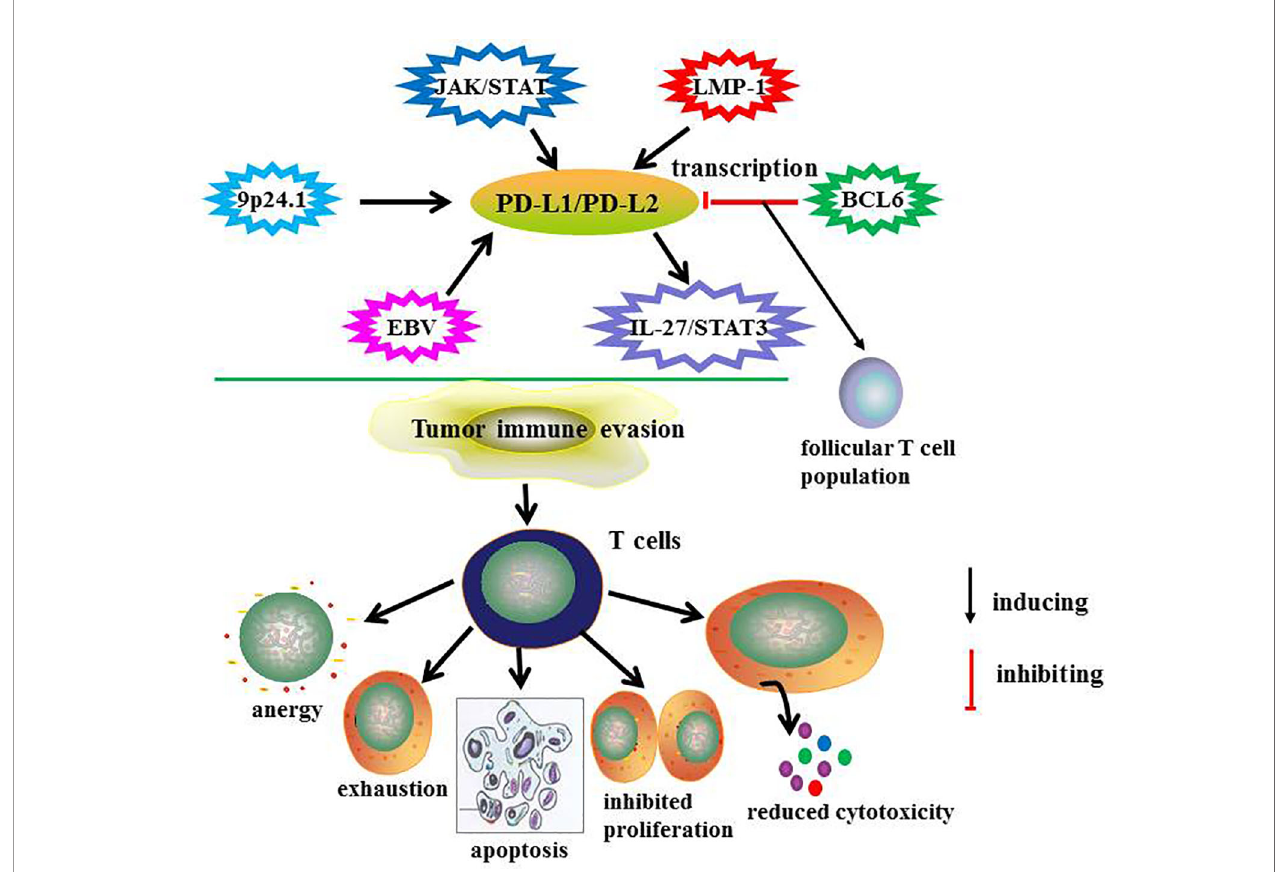
FIGURE 2 | The regulatory mechanisms and function of PD-L1/PD-L2 in